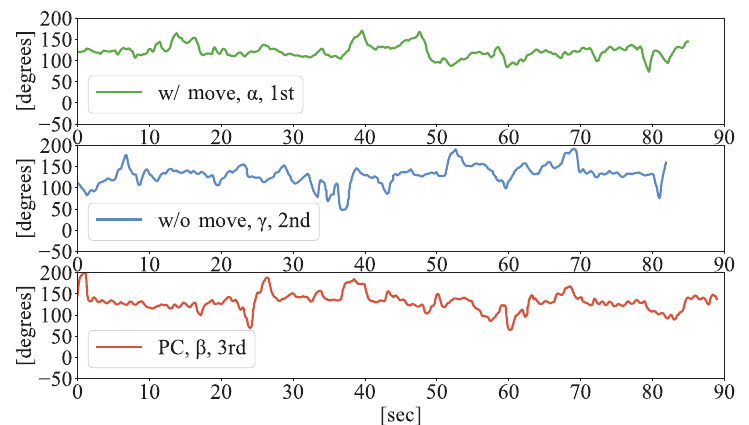
Figure 6. Raw yaw-axis data (P-A).